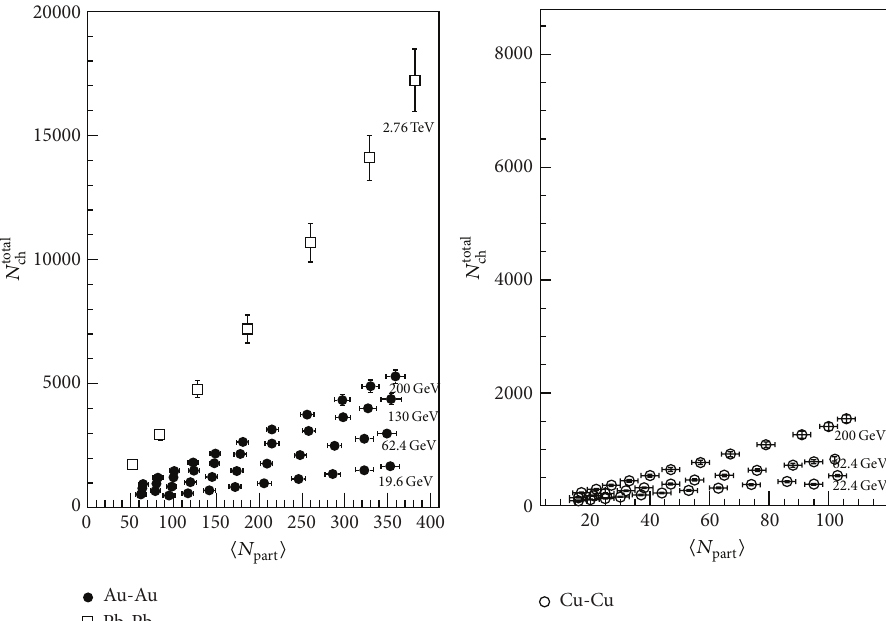
⟩ ). The experimental data has been taken from [118, 119]. ) as a function of centrality ( ⟨𝑁 ch part